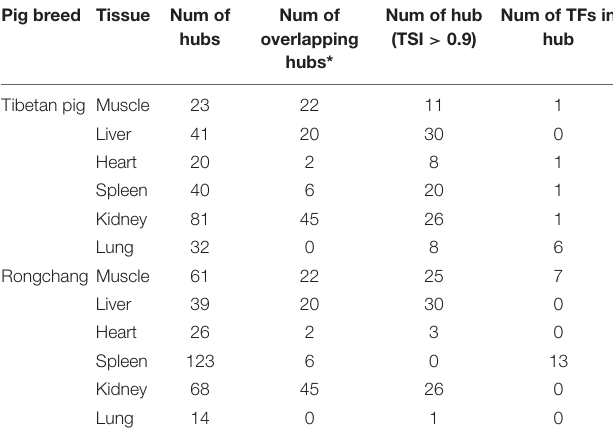
TABLE 3 | Hub gene information of key modules in Tibetan pigs and Rongchang pigs. Pig breed Tissue Num of